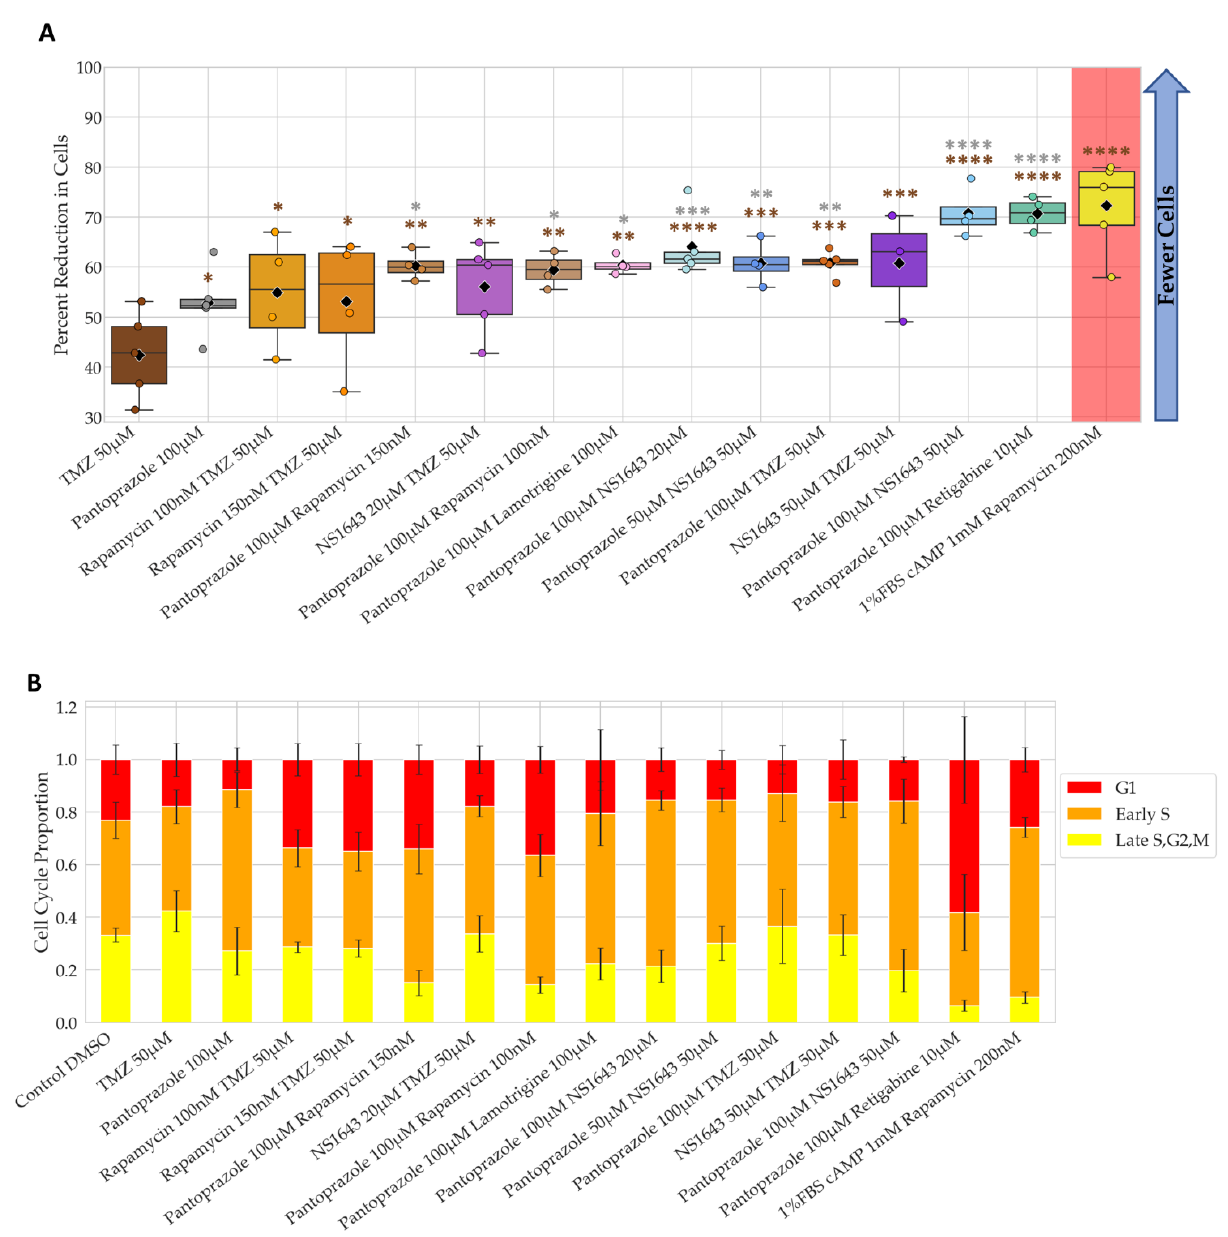
Figure 5. Treatments with Bioelectric Compounds and Pantoprazole or TMZ were Significantly Better than TMZ or Pantoprazole Alone at Reducing Proliferation in U87 cells and Changed the Cell Cycle Ratio Compared to Control. ( A ) Percent reduction in cells compared to control after 6 days of treatment. Treatments that were significantly more effective than TMZ alone are shown out of 42 treatments with brown stars. Treatments with pantoprazole that were significantly better than pantoprazole alone are shown out of 18 treatments with grey stars. Red shaded treatment corresponds to positive control that cannot be used clinically. Statistical analysis was conducted on the log2 of the fold change in cell number to control on day 6. ****: q < 0.0001, ***: q < 0.001, **: q < 0.01, *: q < 0.05 (one-way ANOVA with FDR post hoc analysis n > 3 biological replicates). ( B ) FUCCI cell cycle data at day 6. Increased red and